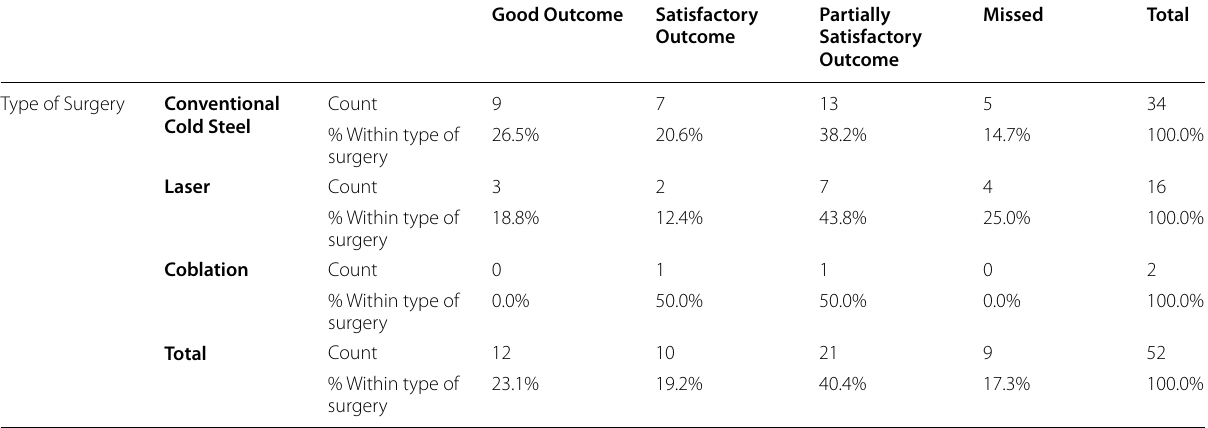
Table 2 Frequency distribution of the cases according to the type of surgery in relation to the outcome Good Outcome Satisfactory